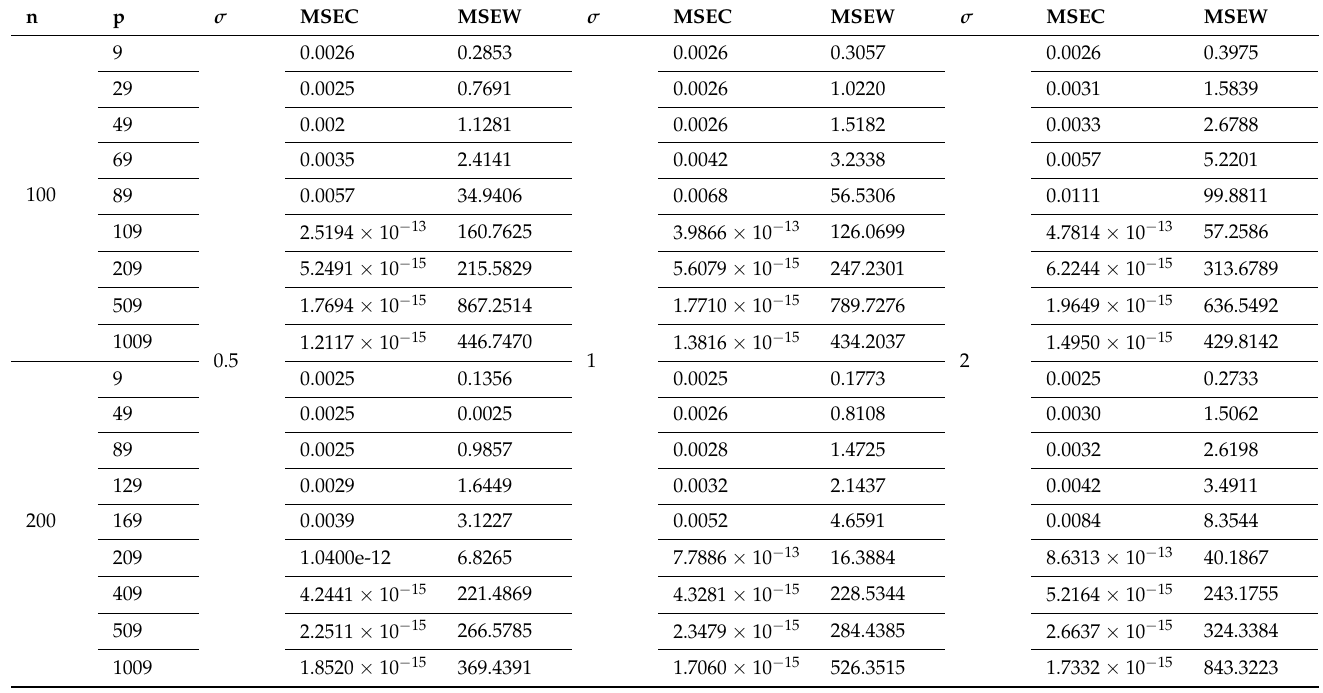
Table 1. Comparison of the mean square errors under different